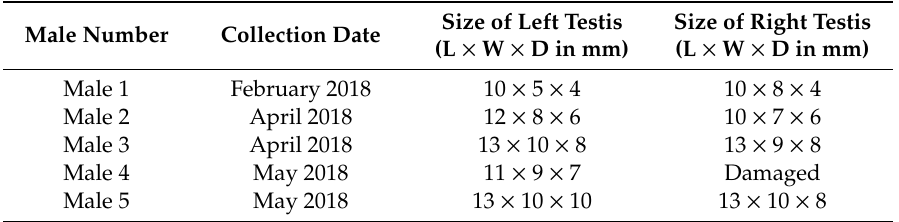
Figure 1. Testis pair (including epididymis) from an adult black-footed ferret. Bar = 1 cm. Table 1. Testicular sizes of five adult black-footed ferrets during the 2018 breeding